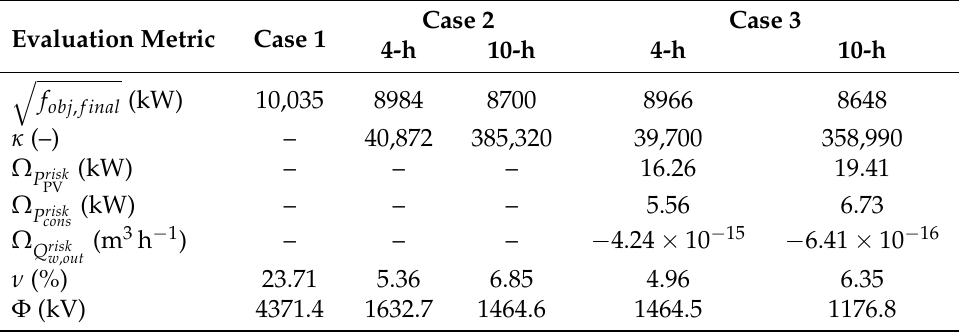
Table 1. Assessment of the min–max problem’s contribution to the control strategy’s robustness to forecasting errors, for a week in April. See below (Section 5.3) for details about the three cases. For Case 2 and Case 3, 4 h and 10 h sliding windows are